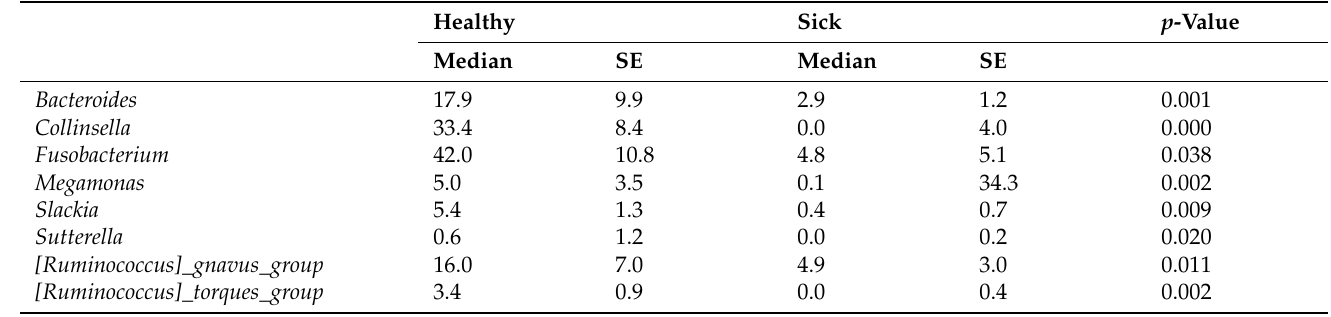
Figure 5. Principal coordinate analysis (PCoA) plots of the ( A ) weighted and ( B ) unweighted UniFrac beta diversity of the fecal microbiome of healthy (red dots) and sick (blue dots) dogs. Table 5 shows the fecal genera showing significant differences between the two groups. Bacteroides , Collinsella , Fusobacterium , Slackia , Sutterella , Ruminococcus gnavus group, and Ruminococcus torques group show a decrease in relative abundances in the feces of sick dogs. Megamonas is the only genus that shows a significant increase in relative abundances in the feces of sick dogs. Table 5. Kruskal–Wallis non-parametric test of the relative abundances (RAs) of genera, characterizing the fecal samples of healthy and sick dogs. Mean and standard deviation (SD) are reported. p -value below 0.05 denotes